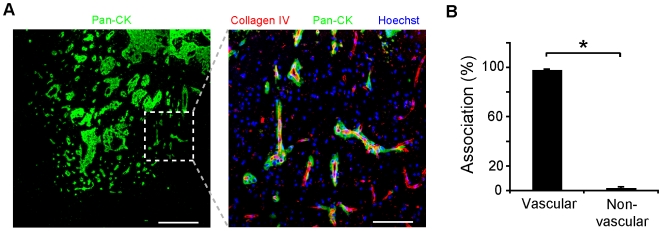
Vascular cooption in human brain metastasis.(A) Human carcinomatous metastasis from lung primary tumor (third case in Table 1) demonstrates vascular association. Right, high power view of hatched region. Scale bars, 0.5 mm (left), 120 µm (right). (B) Quantitation of vascular association in human brain metastasis specimens of diverse primary origin from six patients (*P<0.001, t-test, n = 3420 tumour profiles from 6 patients; Table 1). Error bars represent s.d.